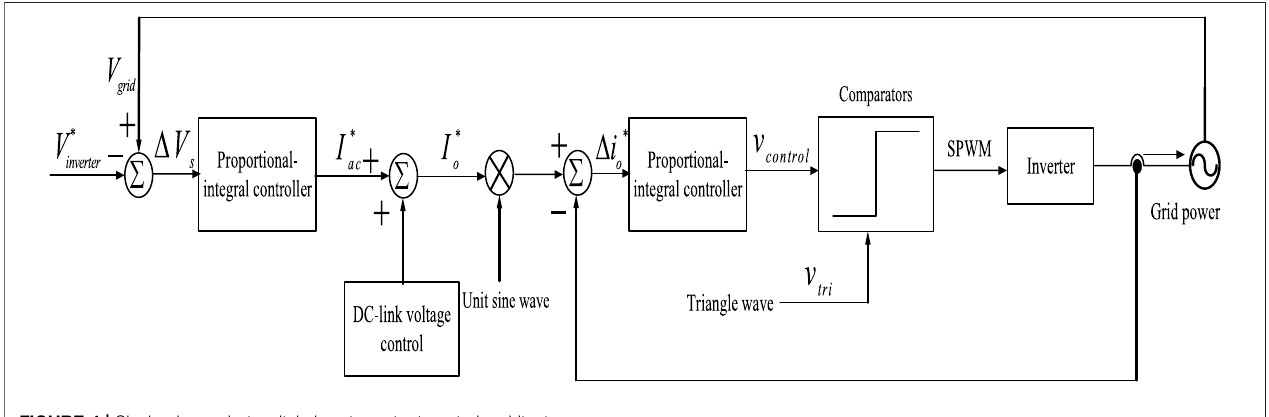
FIGURE 4 | Single-phase photovoltaic inverter output control